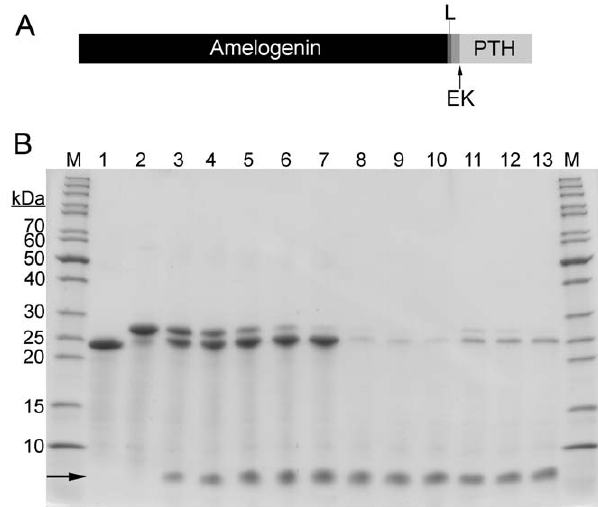
Figure 3. A ) Schematic structure of the amelogenin-PTH fusion protein. The amelogenin (in the N-terminal) and PTH (in the C-terminal) are separated by a glycine-serine linker (L) and an enterokinase site (EK). The arrow indicates the cleavage point of enterokinase. B ) SDS-PAGE gel for analysis of amelogenin-PTH cleavage with enterokinase. Lane 1 is amelogenin purified with acid/heat treatment method and lanes 2–7 are purified amelogenin-PTH at different time points during enteroki- nase cleavage: 0 h, 1 h, 2 h, 4 h, 8 h and 24 h. Lanes 8–10 are samples after 4 h, 8 h and 24 h of cleavage where the amelogenin and amelogenin-PTH have been removed by precipitation at pH 7. Lanes 11–13 are also samples after 4 h, 8 h and 24 h of cleavage, but here the amelogenin and amelogenin-PTH have been removed by precipitation using 250 mM NaCl. Lanes marked M contain molecular weight marker. PTH is indicated with an